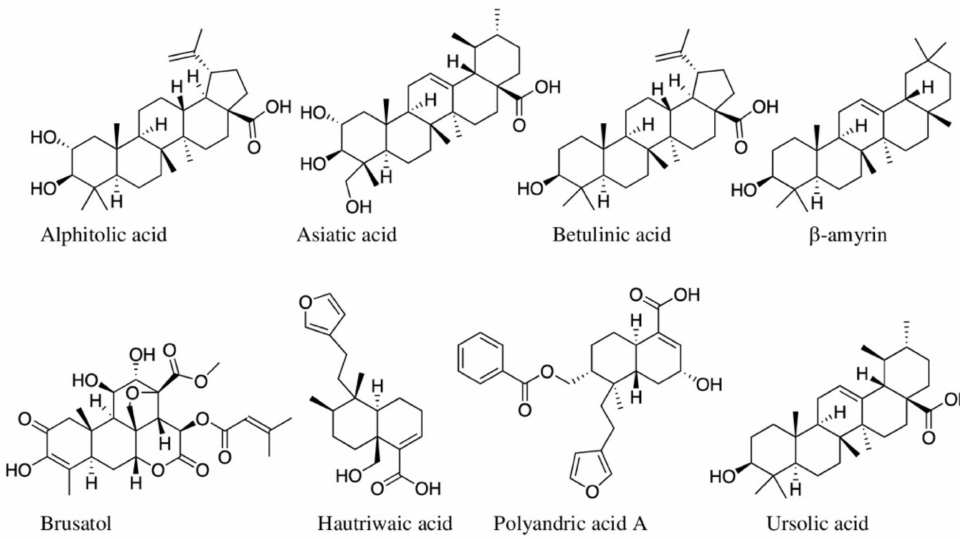
Figure 5. Chemical structures of anti-inflammatory terpenes and